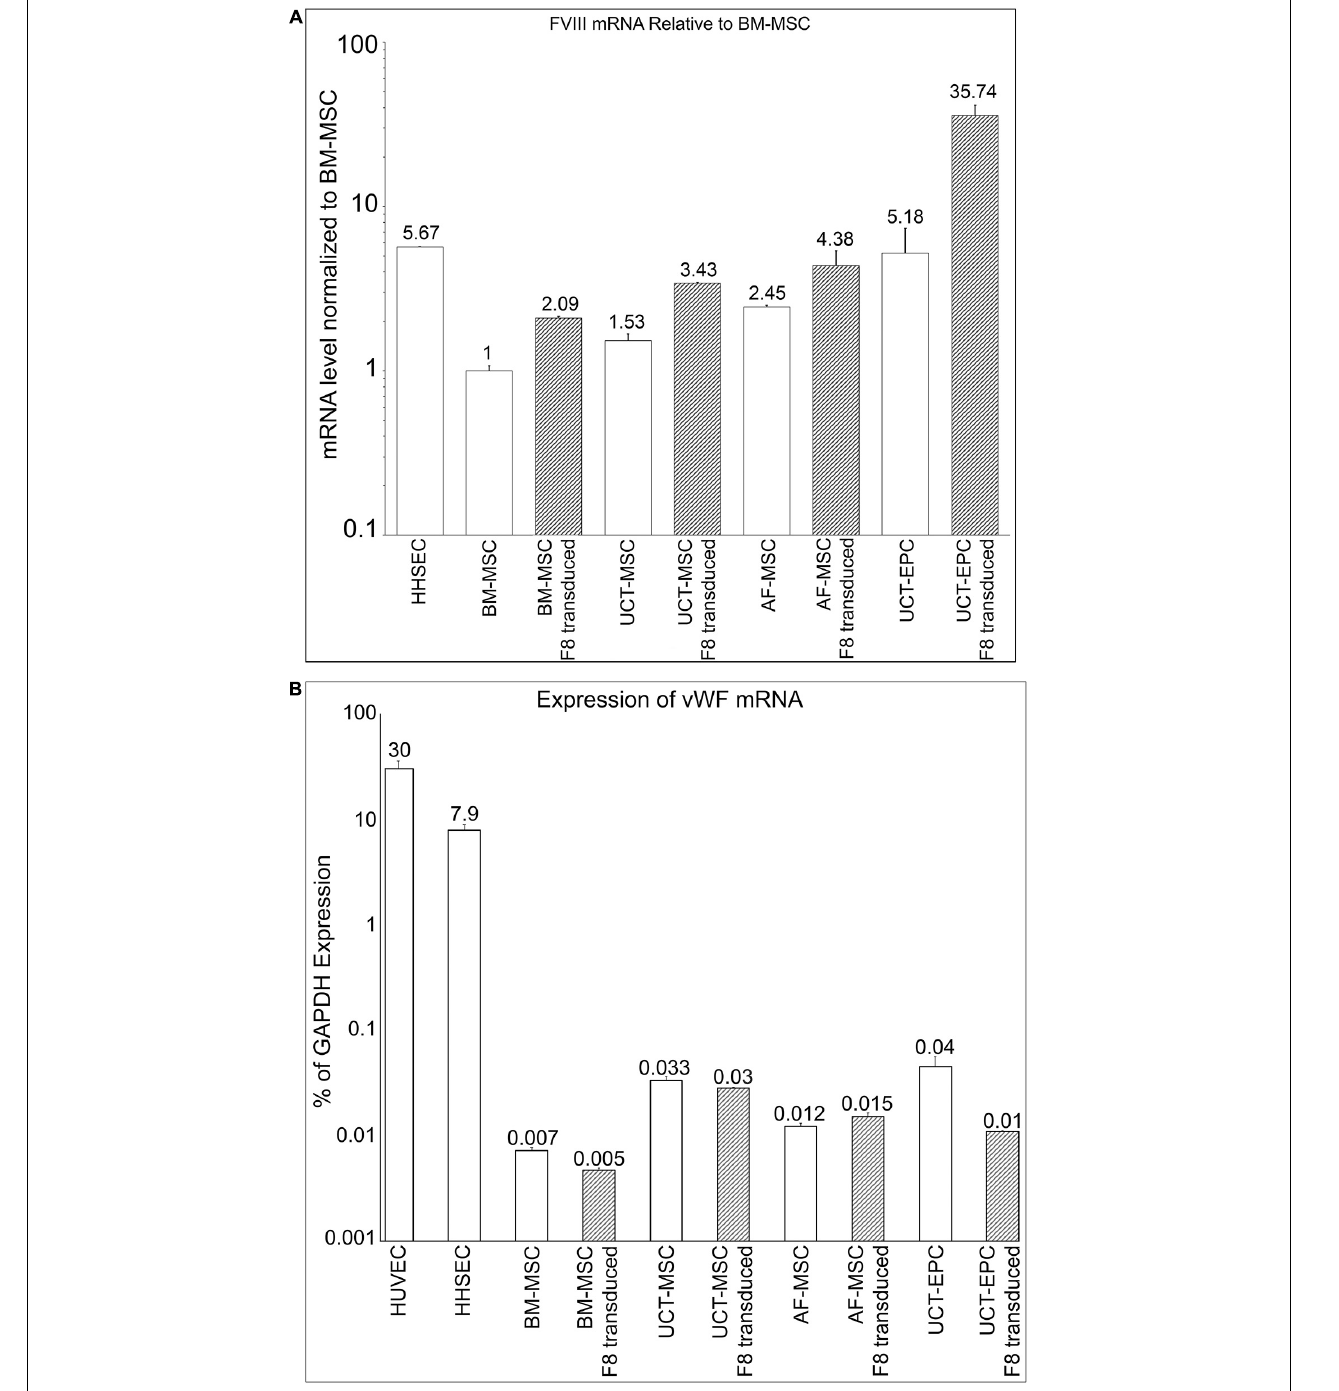
FIGURE 3 | (A) Quantification of FVIII mRNA in the different cell populations prior to (open bars) and following (hatched bars) transduction with an HSQ-encoding MMLV vector was performed by RT-qPCR. Human hepatic sinusoidal endothelial cells (HHSEC) were used as a positive control. The level of FVIII mRNA in untransduced BM-MSC was set equal to “1” and the level of FVIII mRNA in each of the other samples is expressed as fold-difference relative to that value. Values represent the average of two different donors (biological replicates) for each cell type and 6 independent experiments. Error bars represent standard error of the mean (SEM). (B) Quantification of vWF mRNA in the different cell populations prior to (open bars) and following (hatched bars) transduction with an HSQ-encoding MMLV vector was performed by RT-qPCR. Human hepatic sinusoidal endothelial cells (HHSEC) and HUVEC were used as positive controls. The levels of vWF mRNA are expressed as a percentage of each sample’s respective level of GAPDH mRNA. Values represent the average of two different donors (biological replicates) for each cell type and 6 independent experiments. Error bars represent standard error of the mean (SEM).